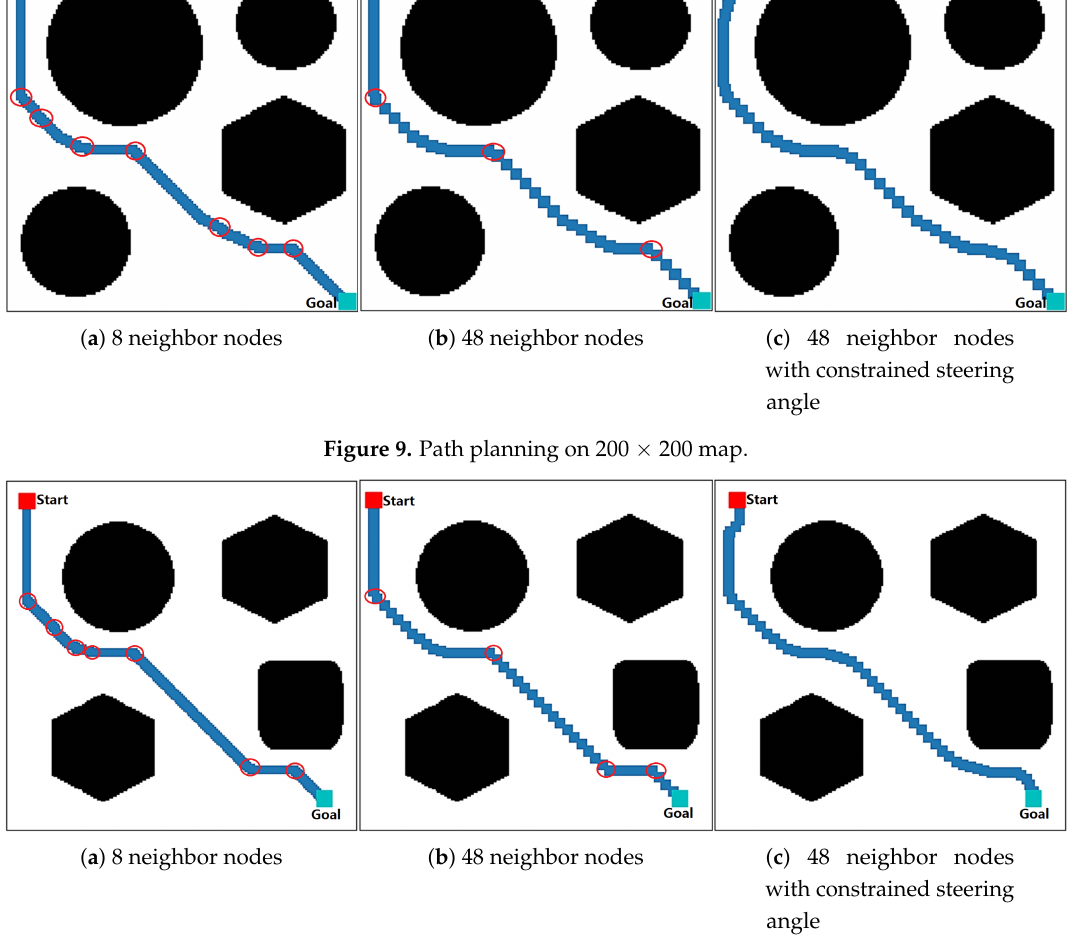
Figure 10. Path planning on 400 × 400